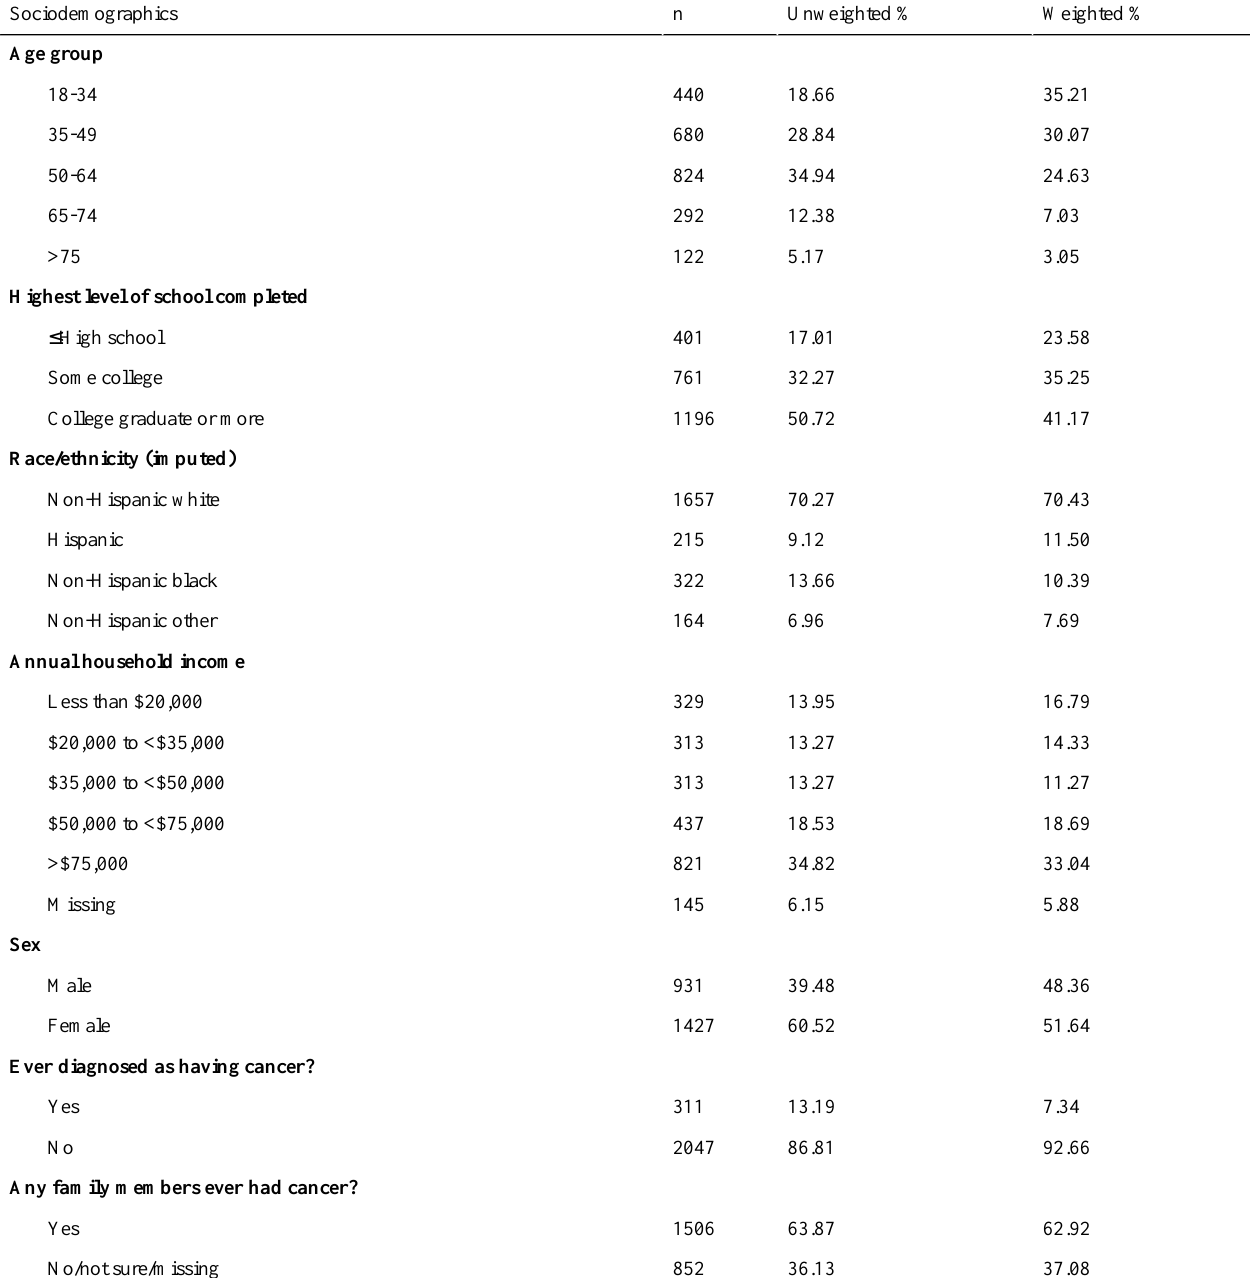
Table 1. Weighted and unweighted unadjusted prevalence estimates for sample demographics, Health Information National Trends Survey (HINTS) 4 Cycle 1, October 2011 to February 2012